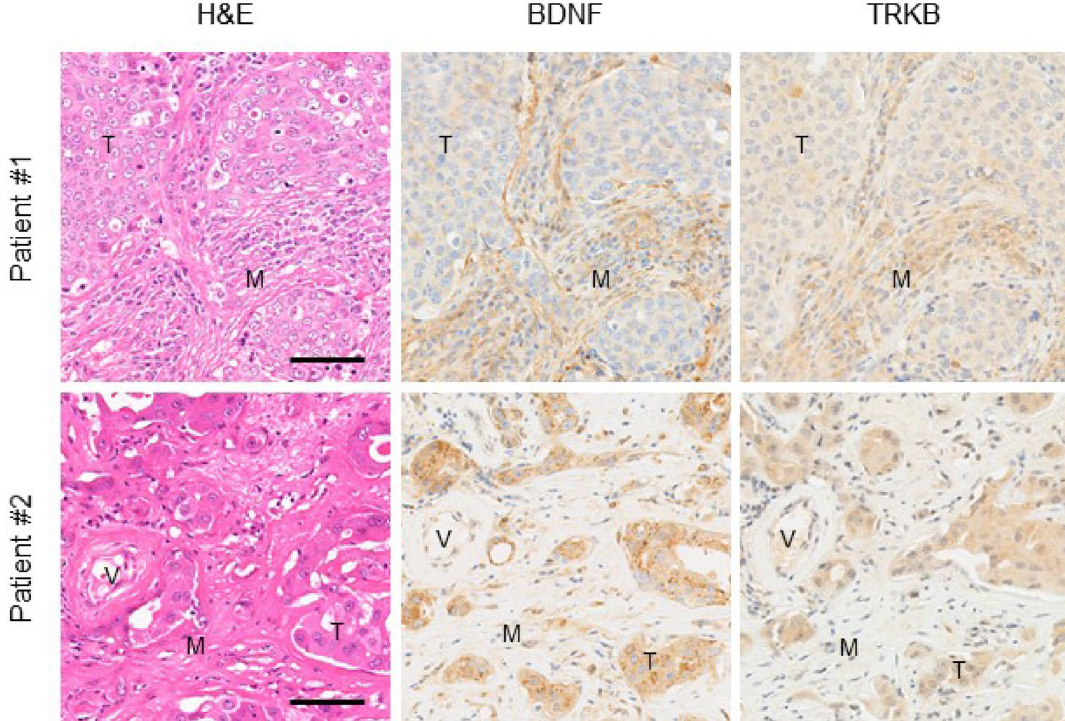
Figure 1. High expression of BDNF and TRKB in cancer cells and mesenchymal cells in PGC tissues. Representative images of H&E and immunostaining of BDNF and TRKB in tumor tissues from patients with PGC. Note that staining for BDNF and TRKB was detected in cancer cells as well as in mesenchymal cells such as fibroblasts and endothelial cells. Scale bars, 100 μm. T tumor area, M mesenchymal area, V